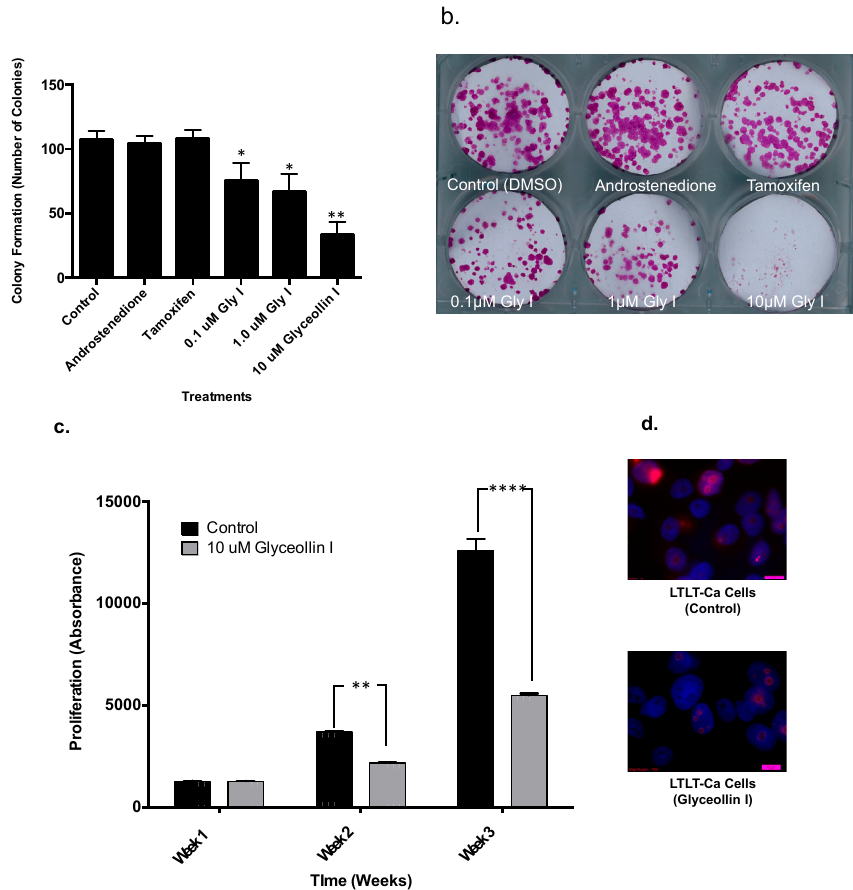
Figure 1. ( a , b ) Glyceollin I decreases the viability of letrozole resistant breast cancer cells. Letrozole resistant (LTLT-Ca) cells were treated with control (DMSO), androstenedione, tamoxifen and 0.1 µ M, 1.0 µ M and 10 µ M glyceollin I and cell viability studies were performed. Graph depicts the percentage